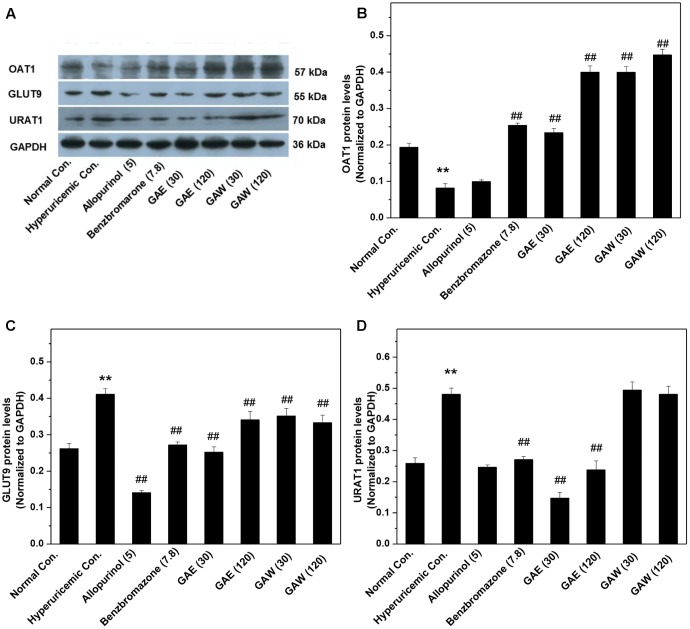
Effects of G. applanatum extracts on the protein levels of renal ion transporters. The kidney cortex protein was extracted for Western blot analysis of OAT1 (A,B), GLUT9 (A,C), and URAT1 (A,D). ∗∗P < 0.01 as compared to the normal control; ##P < 0.01 as compared to the hyperuricemia control.